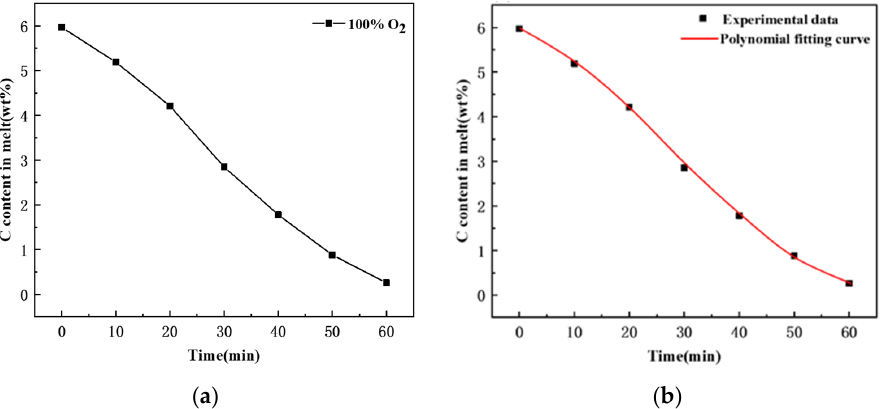
Figure 8. Variation in carbon content with time in melt when blowing pure O 2 : ( a ) variation in C content in melt; ( b ) fitted curve of variation in C content in melt.